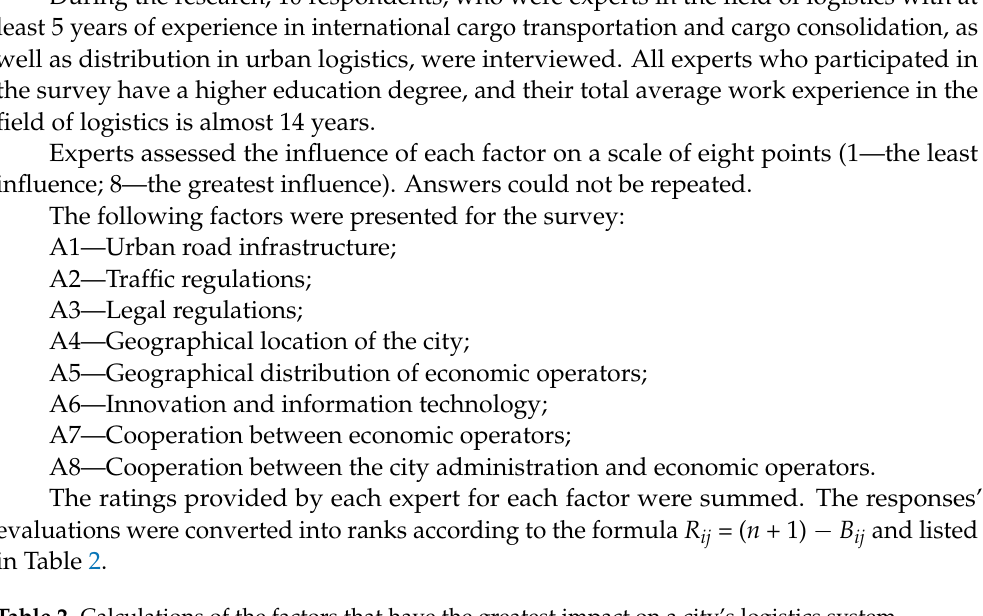
Table 2. Calculations of the factors that have the greatest impact on a city’s logistics system.